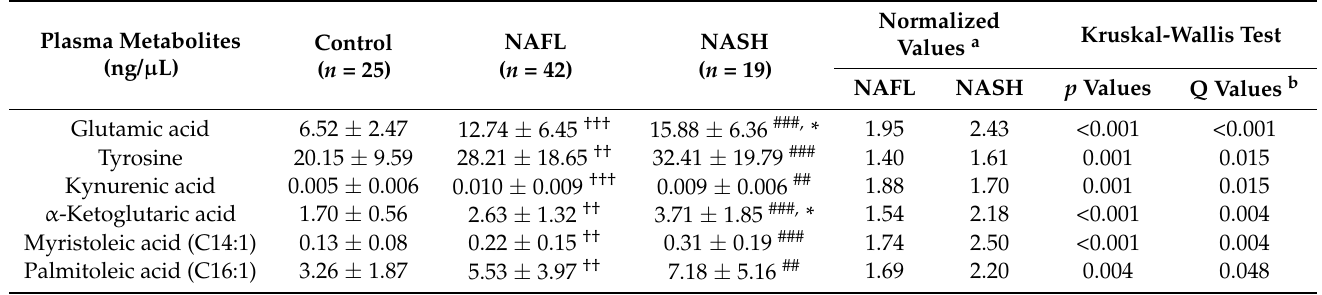
Table 2. Plasma levels of six significantly different metabolites in the control, NAFL, and NASH